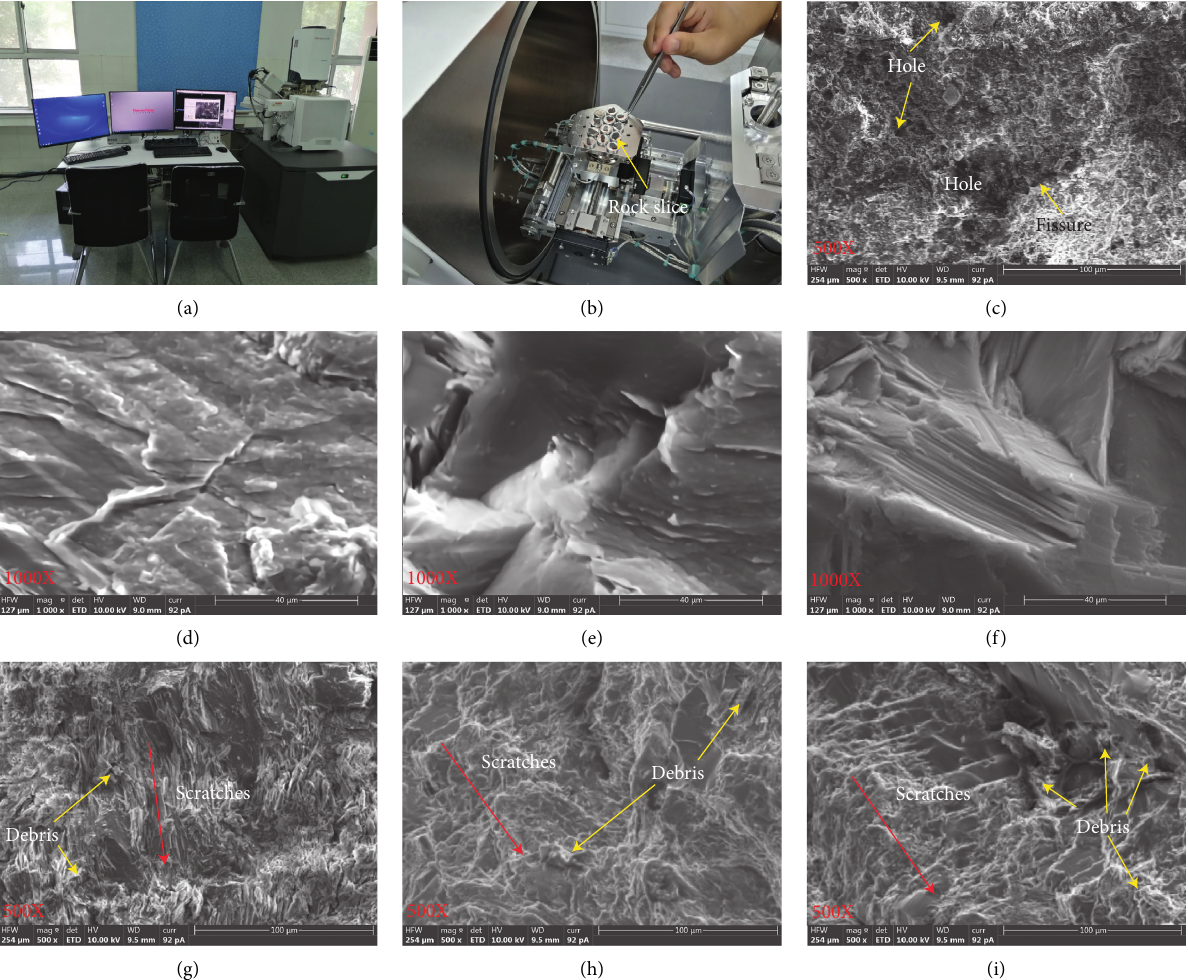
Figure 12: SEM photomicrograph of Yunnan limestone fracture surface for different test cases. (a) Electron microscope scanning system. (b) Rock slice on the fracture surface. (c) Internal structure in the initial state. (d) Direct tensile test. (e) Uniaxial compression test (confining pressure � 0MPa). (f) Triaxial compression test (confining pressure � 10 MPa). (g) Triaxial compression test (confining pressure � 20MPa). (h) Triaxial compression test (confining pressure � 30MPa). (i) Triaxial compression test (confining pressure � Table 6: Fitted strength parameters of the Yunnan limestone based on the generalized H-B strength criterion. Parameter type